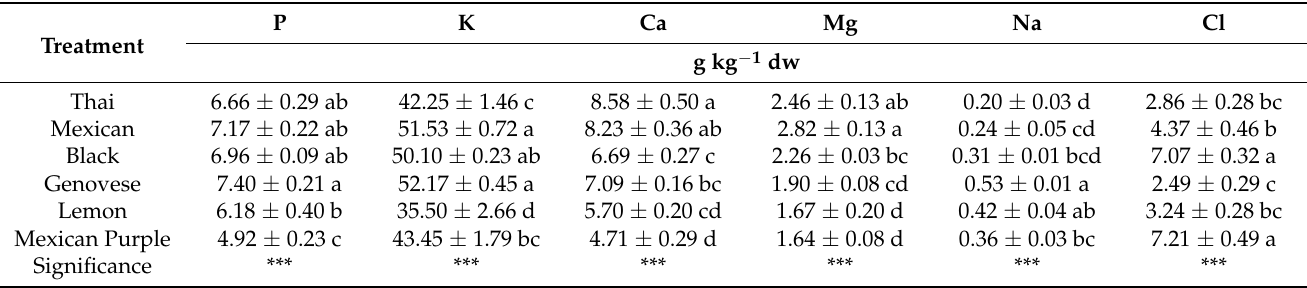
Table 4. Comparison of Thai, Mexican, Black, Genovese, Lemon, and Mexican Purple basil mineral concentration.